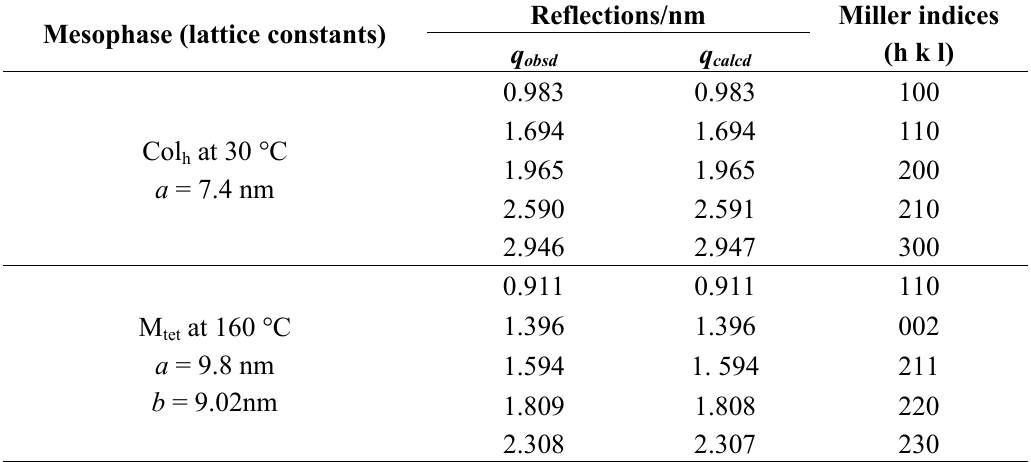
Table 4. Small-angle X-ray diffraction data for molecule 1c in the bulk